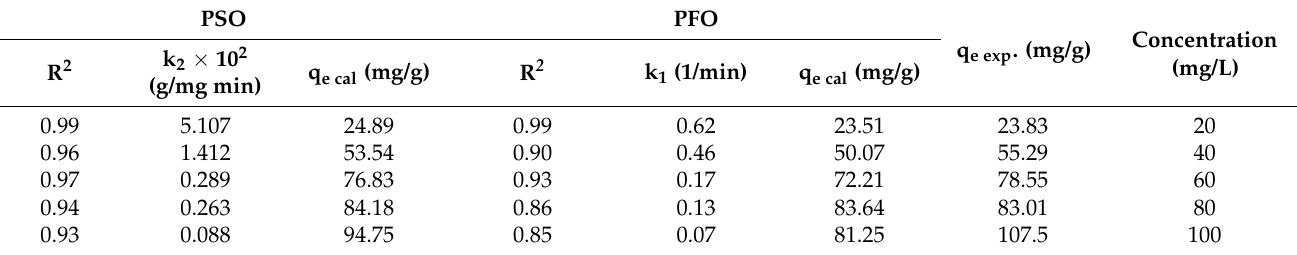
Table 6. PFO and PSO kinetic parameters for MB dye adsorption on BWAC.